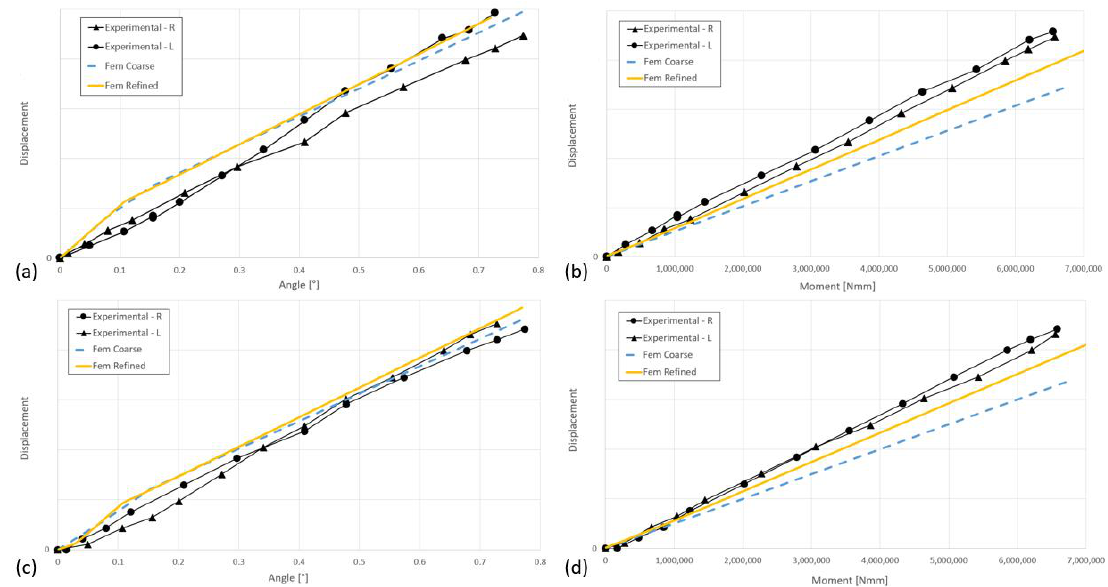
Figure 13. Comparison between experimental and FE displacement in the distributed bending: ( a ) Measured at laser position, as a function of the rotation angle; ( b ) measured at laser position, as a function of the moment; ( c ) measured at cable position, as a function of the rotation angle; ( d ) measured at cable position, as a function of the moment.